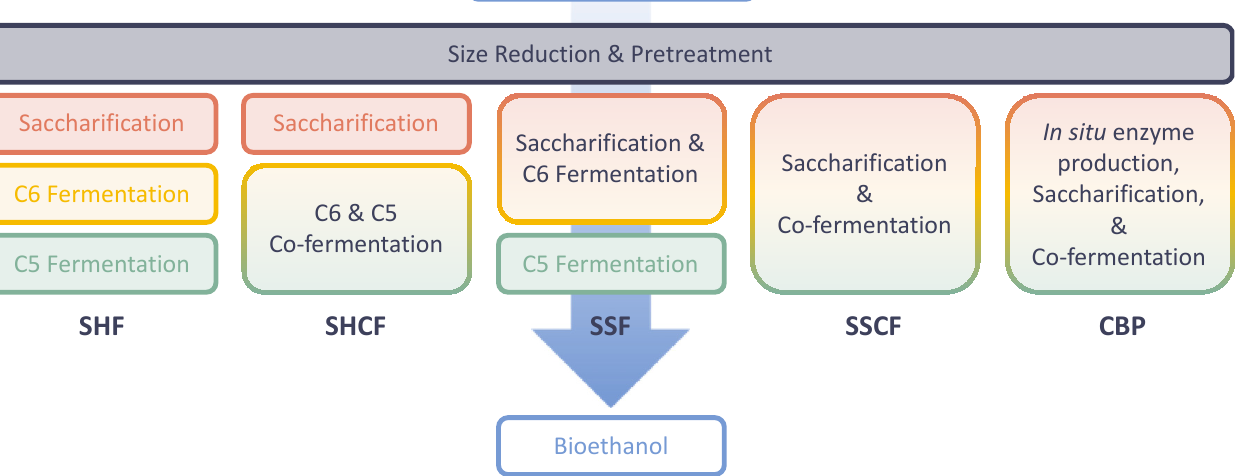
Figure 4. Schematic representation of different step integration strategies.